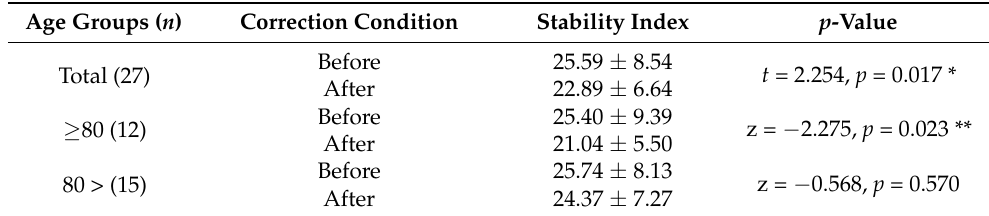
Figure 2. Changes in stability index before and after wearing corrective glasses in all participants ( n = 27). * p < 0.05 by paired t -test. Table 2. Changes in stability index before and after wearing corrective glasses according to age groups.